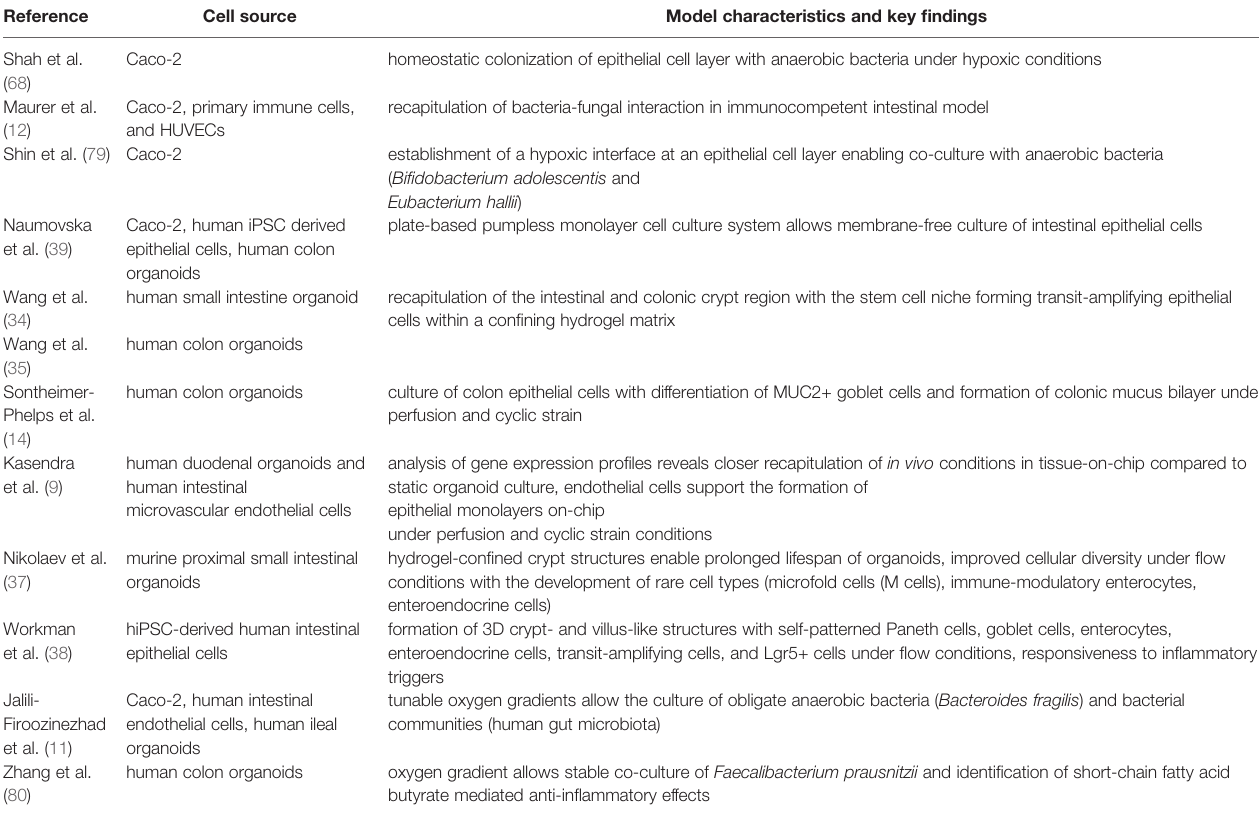
TABLE 2 | Key references of selected gut-on-chip systems with important characteristics to recapitulate the gut environment. Reference Cell source Model characteristics and key fi ndings